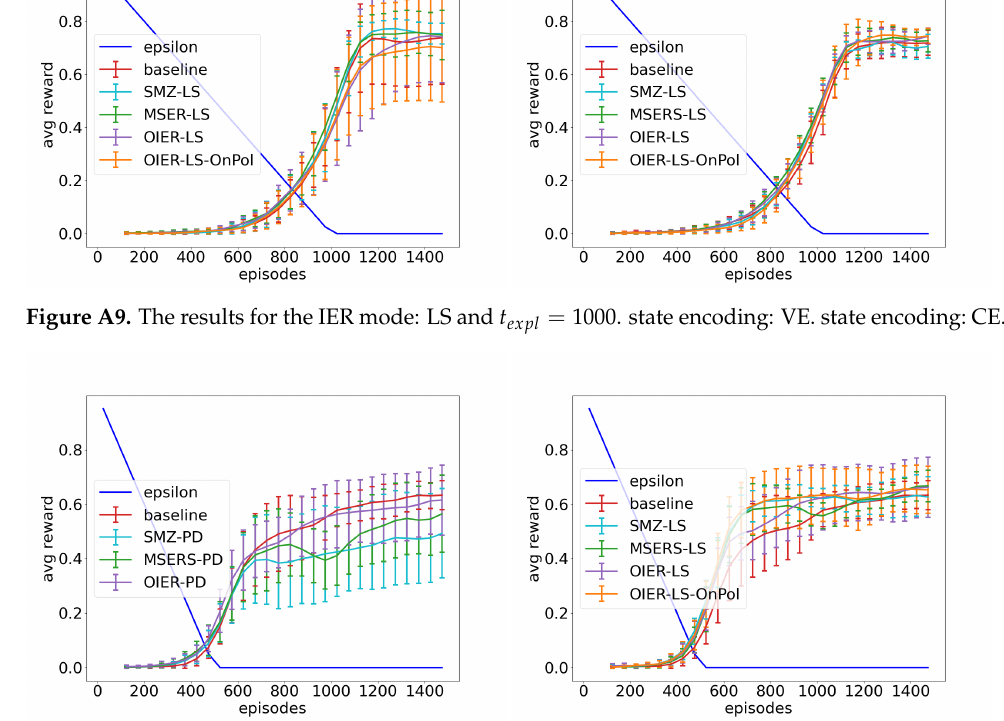
Figure A10. The results and state encoding for: LKE and IER mode: PD. t expl = 500. t expl =